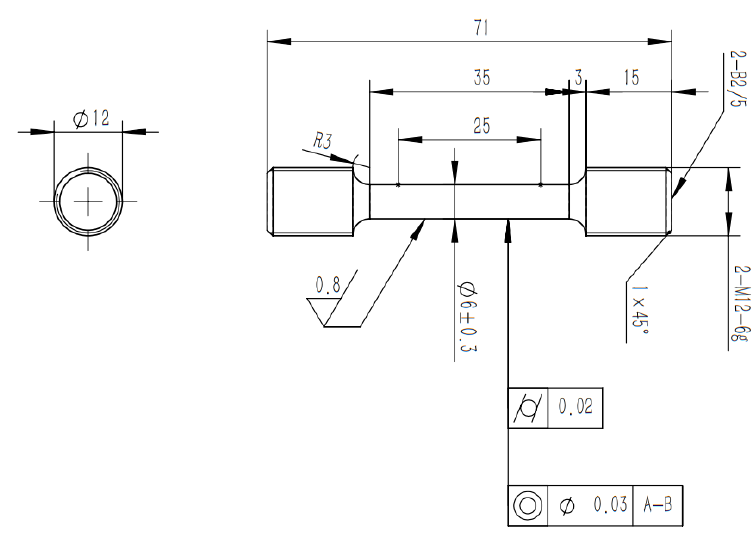
Figure 2. Schematic showing the samples for tensile tests (unit: mm). Transmission electron microscope scanning (TEM) was performed using FEI Tecnai G2 F20, 200KV instrument. Samples after CHT with 4 h ageing (under-aged condition) and 20 h ageing (nearly peak-aged condition), after DCT with 20 h ageing (nearly peak- aged condition) were selected for observations. The samples were cut to discs along the stress direction, mechanically thinned to 0.08 mm and then electropolished at − 20 ◦ C [11]. The microscopic precipitates, morphology and characteristics of the samples were